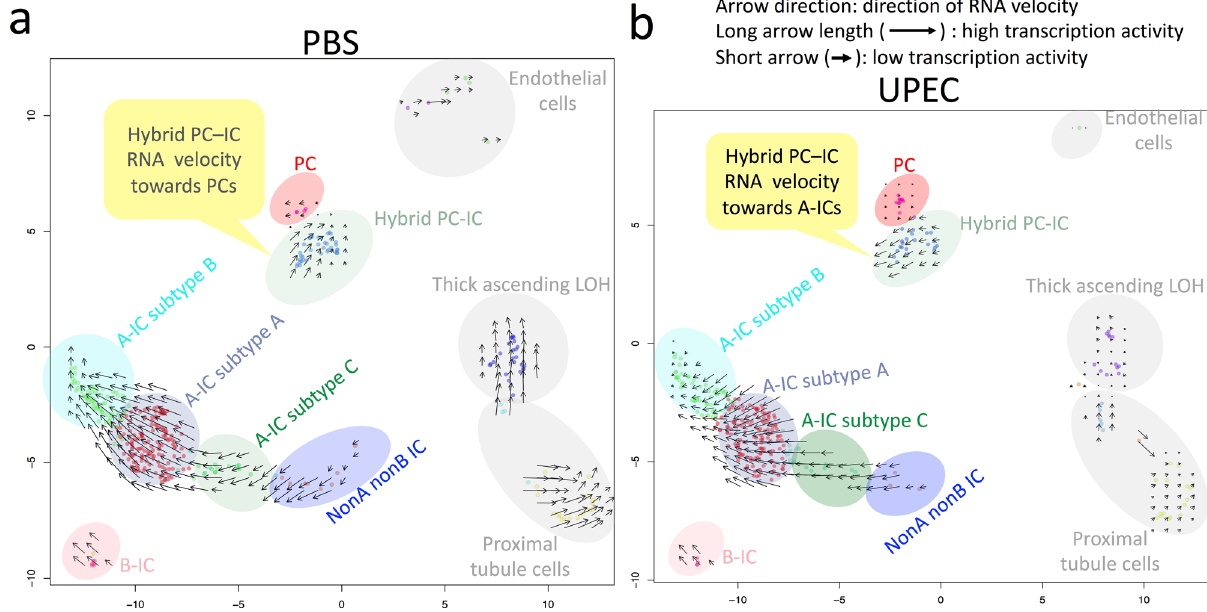
Fig. 5 UPEC exposure results in human hybrid PC – IC RNA velocity toward A-ICs. At baseline ( a ) represented by 1 h of control saline exposure, human hybrid PC – ICs have an RNA velocity that moves counterclockwise toward PCs. Following 1 h of UPEC exposure, hybrid PC – IC ’ s RNA velocity changes directions toward A-ICs. Also, non-IC cell types, including proximal tubule, PCs, endothelial, and thick ascending loop of Henle (LOH) have much smaller arrows with UPEC exposure ( b ) compared to saline ( a ) indicating that these cells have decreased transcriptional activity in response to infection. In contrast, ICs had similar sized arrows with saline and UPEC exposure, indicating that they maintain their transcriptional activity when infected. The color shade of the collecting duct cell clusters matches the cluster color in Fig. 1, while the non-collecting duct kidney cell clusters are shaded